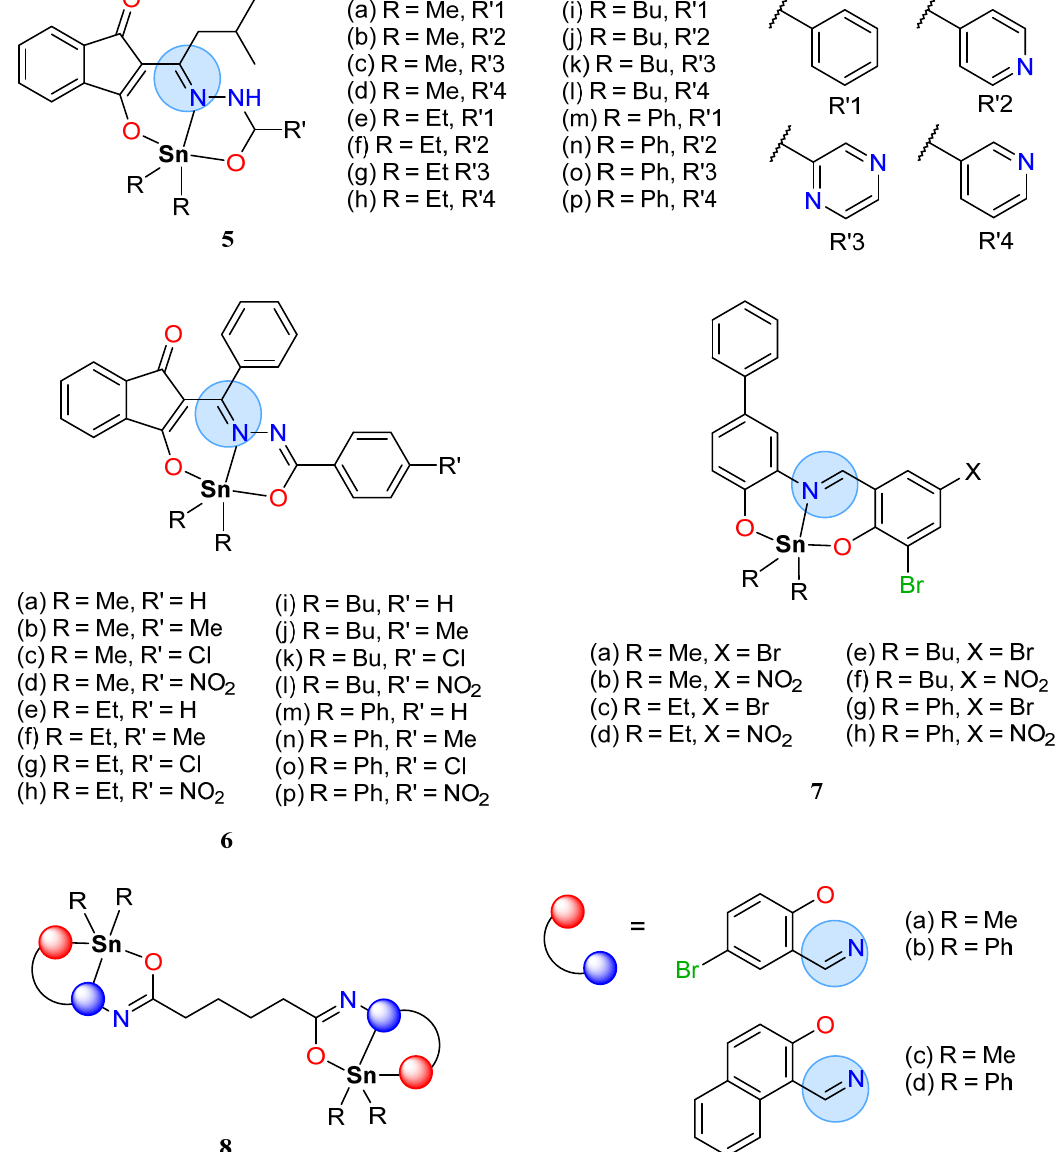
Figure 5. Organotin(IV) complexes with tridentate ONO donor Schiff base ligands tested for antimicrobial activity.